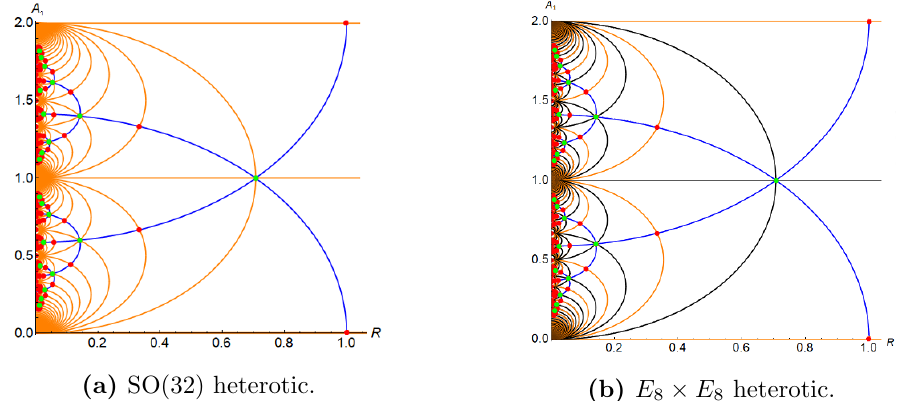
(a) SO(32) heterotic. Figure 6. Enhancement groups on the left sector of the heterotic theory on the slice of moduli space de(cid:12)ned by A 2 ;:::; 16 = 0. See table 3 for details.